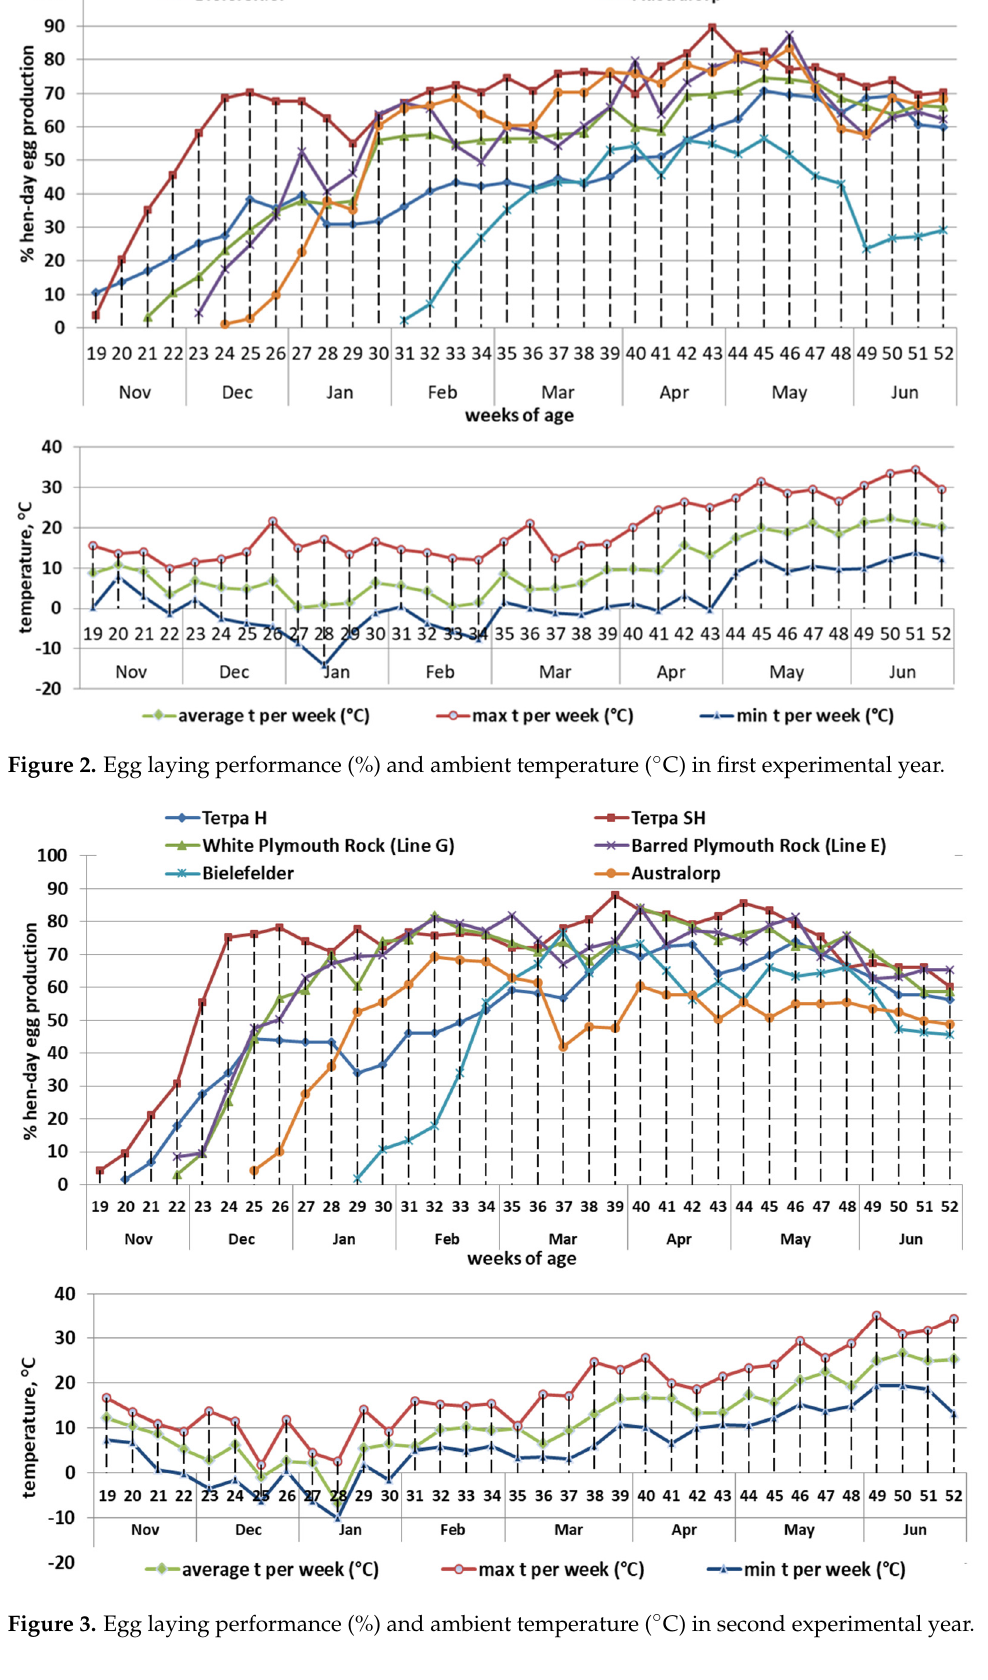
Figure 3. Egg laying performance (%) and ambient temperature (°C) in second experimental year.